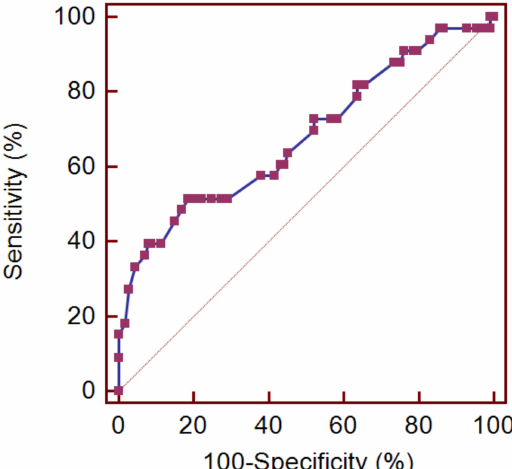
Figure 4. Receiver operating characteristic curve analysis to determine the ability of pain duration after lumbar surgery to predict successful response to combined epidural adhesiolysis and balloon decompression. The best cut-o ff point was ≤ 14 months, with a sensitivity of 51.5%, a specificity of 81.4%, and an AUC of 0.680 ( p =